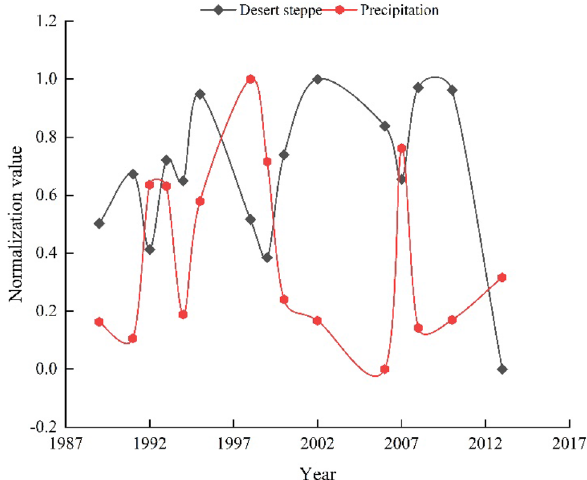
Figure 4. Temporal variation of precipitation. To better compare the variation trend of altitudinal vegetation belt, temperature and precipitation, we normalized the data of temperature, precipitation, and altitudinal belt spectrum. The normalized range of all data is [− 1,